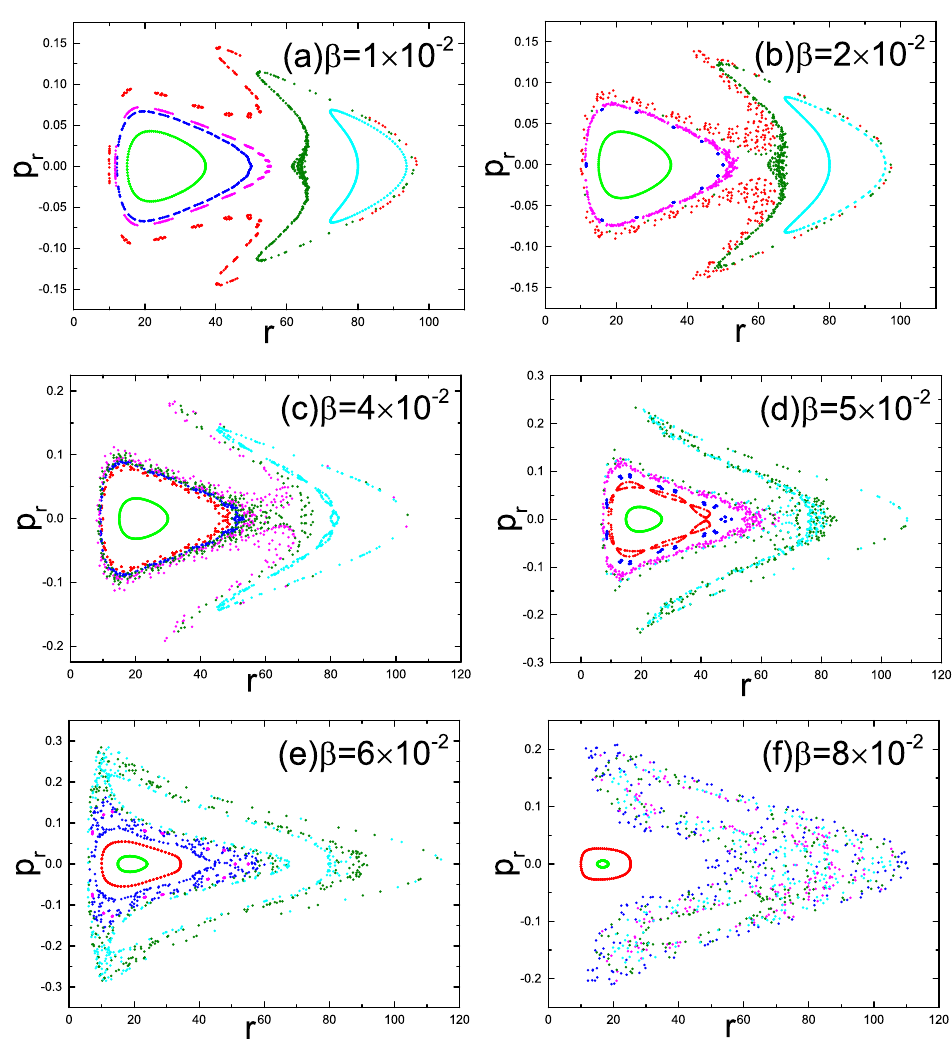
Figure 4. Dependence of the orbital dynamics on the dark matter parameter β . Poincaré sections with the same parameters E = 0.9900, L = 4.1, b = 0.0012, α = 10 − 7 , and different values of dark matter parameter β are given. The corresponding orbits are r =